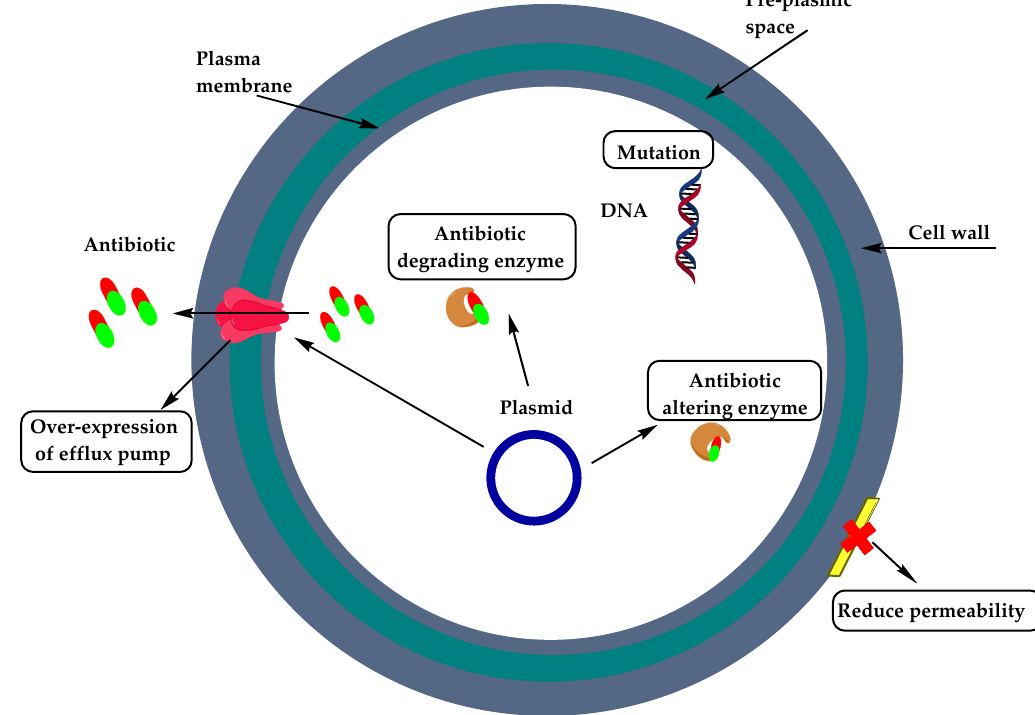
Figure 2. Mechanisms of resistance of Gram-positive bacteria.